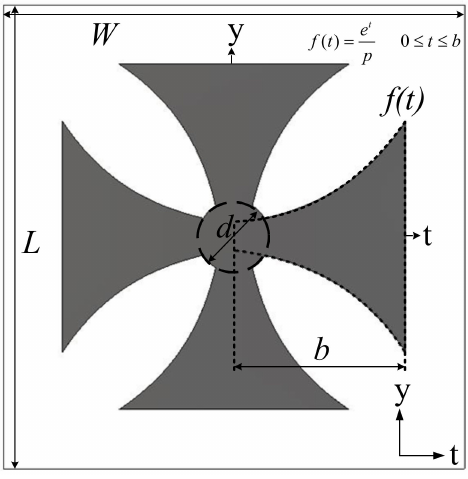
Figure 4. Topology of the crusader-cross-shaped unit cell.